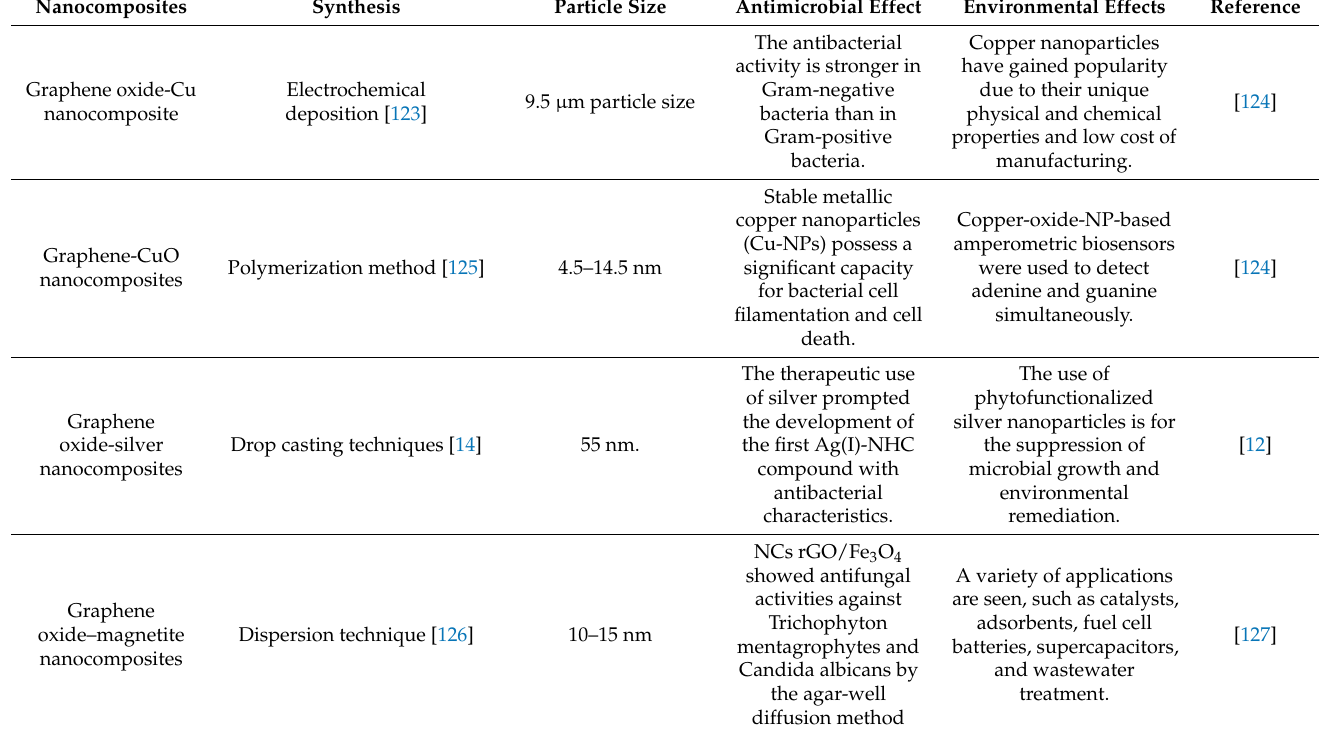
Table 1. List of GM Hybrids for Environmental Applications.